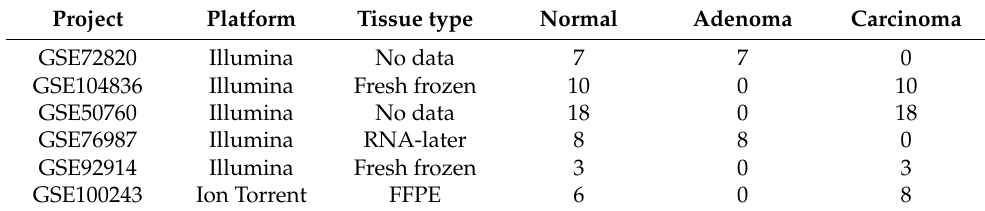
Table 3. Overview of projects included in the